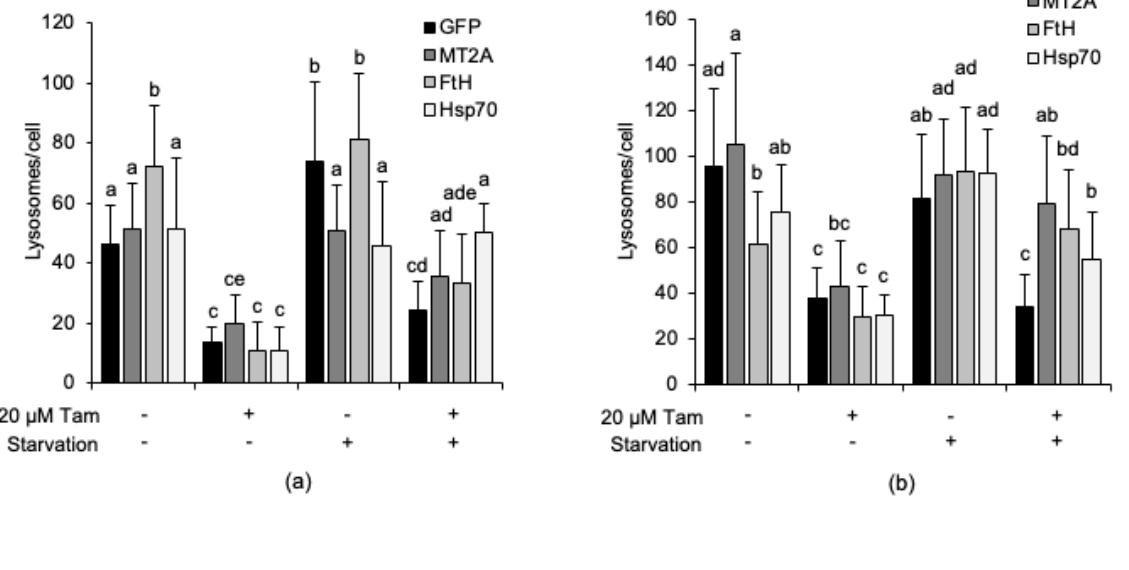
Figure 9. Overexpression of iron-binding proteins and activation of autophagy are both necessary to prevent Tam-induced lysosomal damage in breast cancer cells. ( a , b ) Susceptibility of MDA-MB-415 ( a ) and ZR-75-1 ( b ) cells overexpressing